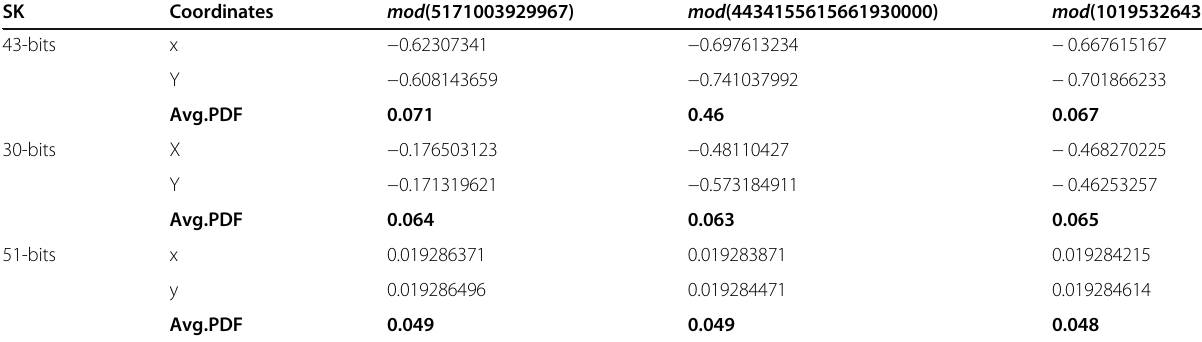
Table 5 Cross correlation of encrypted and non-encrypted data and average PDF values SK